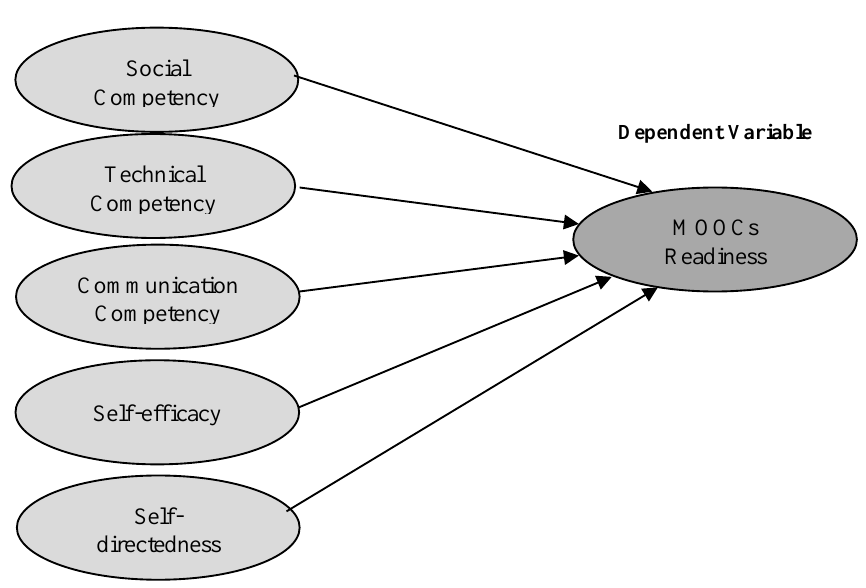
Figure 1. The conceptual framework adapted from “An exploratory factor analysis and reliability analysis of the student online leaning readiness (SOLR) instrument,” by T. Yu and J.C. Richarson, 2015, Online Learning, 19 (5). 2015 by the Online Learning Consortium.